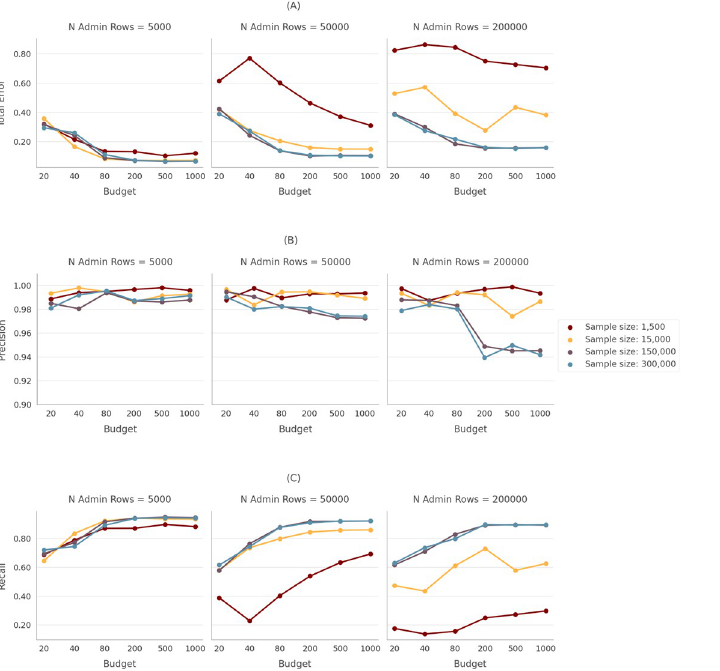
Fig 3. Performance for different sample sizes. A: Total error. B: Precision. C: Recall.